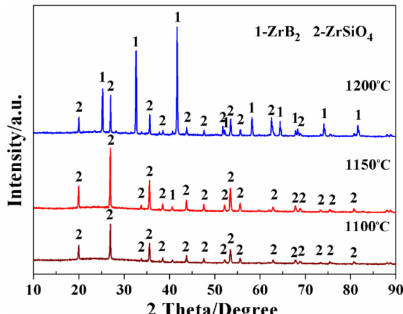
Figure 2. XRD patterns of the samples prepared by the MSM-BCTR method at 1100–1200 ◦ C, without soaking